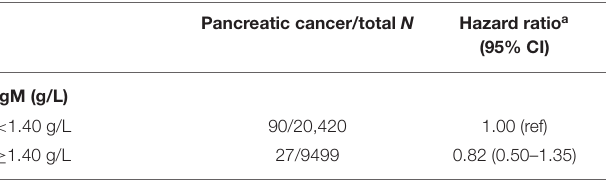
TABLE 7 | Hazard ratio (HR) for risk of pancreatic cancer, in the study population with a measurement of IgM, with 95% confidence intervals (CI) using Cox proportional hazards